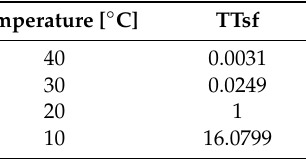
Table 7. Time–temperature shift factors (TTsf) DTC master curve at 20 ◦ C.